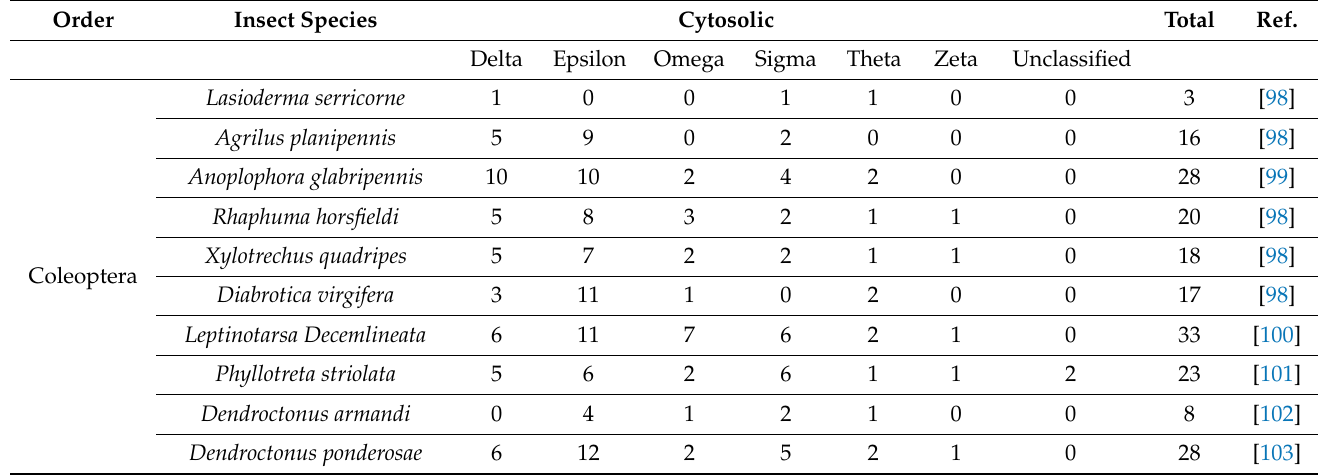
Table 2. Number of identified canonical GSTs in different insect